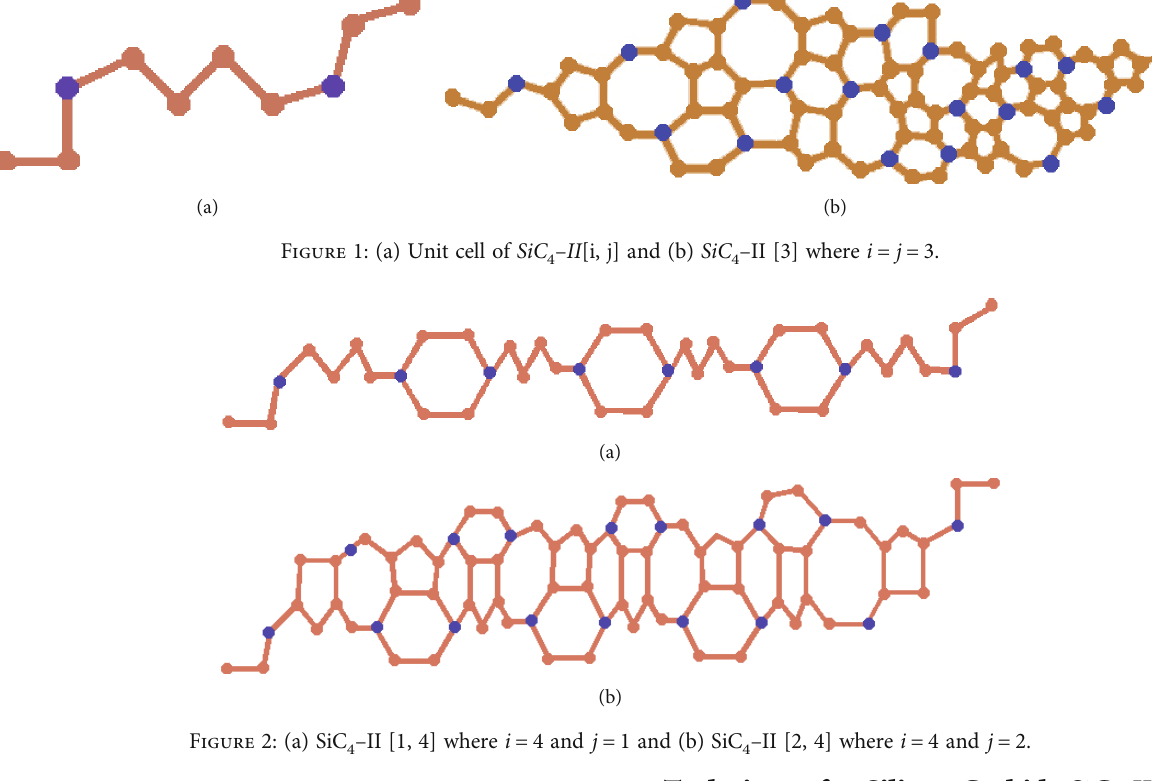
– II [2, 4] where i = 4 and j = 2 4